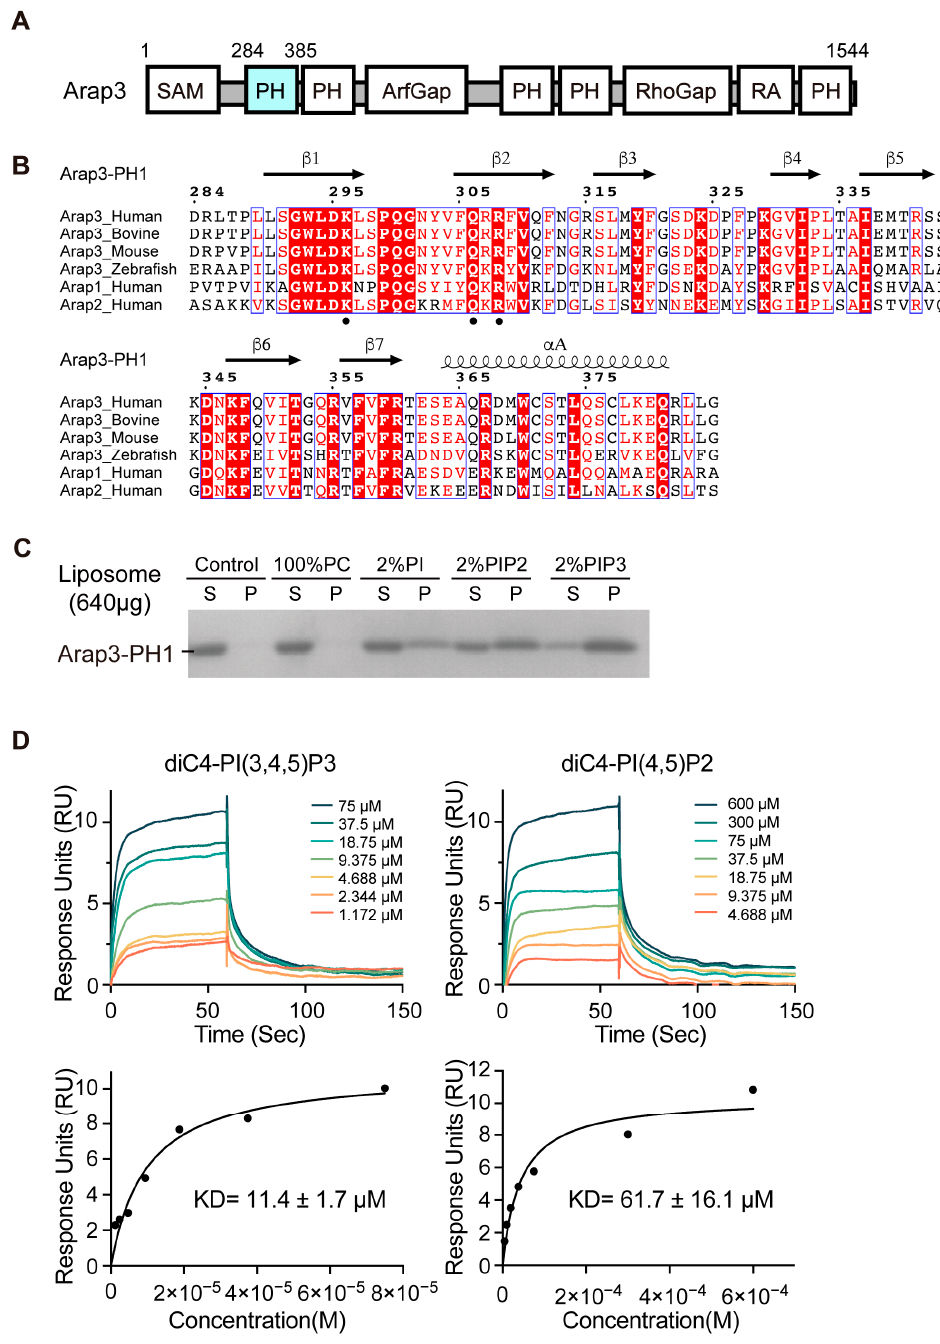
Figure 1. Phospholipid-binding abilities of Arap3-PH1 domain analyzed using liposome pull-down assay and SPR measurements. ( A ) Schematic representation of human Arap3 protein. The first PH domain of Arap3 is marked in cyan. ( B ) Sequence alignment of Arap3-PH1 orthologs in vertebrates and human Arap1-PH1, Arap2-PH1. Sequence accession number in the Uniprot database are: human, Q8WWN8; bovine, E1BBA0; mouse, Q8R5G7; zebrafish, A0A140LH27; human Arap1, Q96P48;